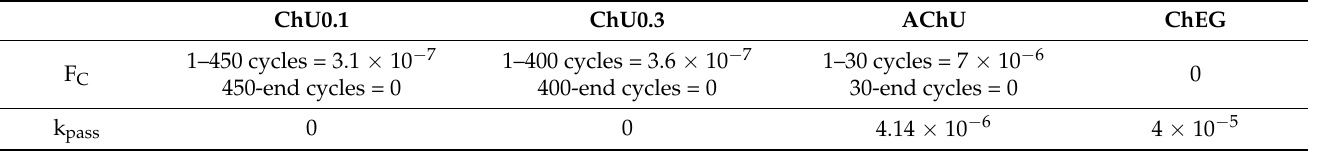
Table 3. F C and k pass values are estimated for the data reported in Figure 12 with the model of [49].